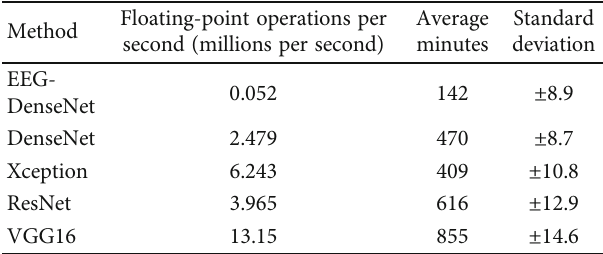
Table 7: Floating-point operations per second and training CPU time of training of all methods.